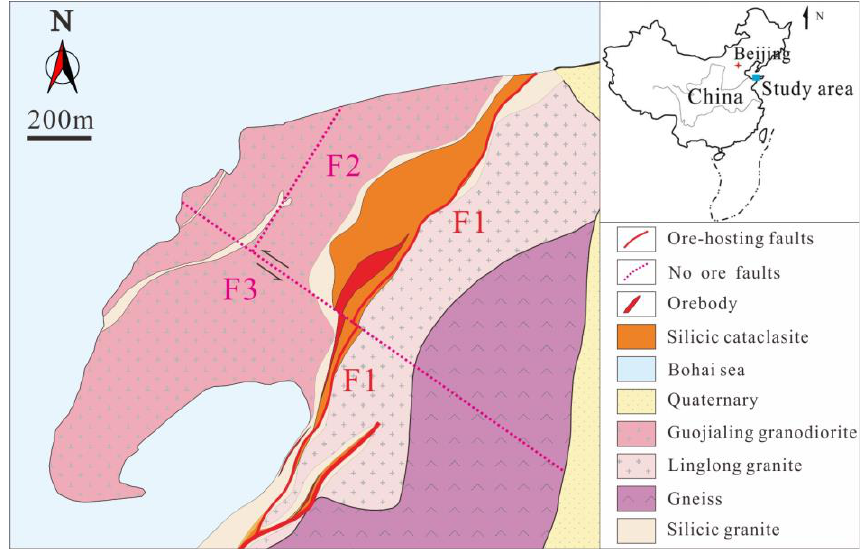
Figure 1. Engineering geological map of the Xinli mining area.